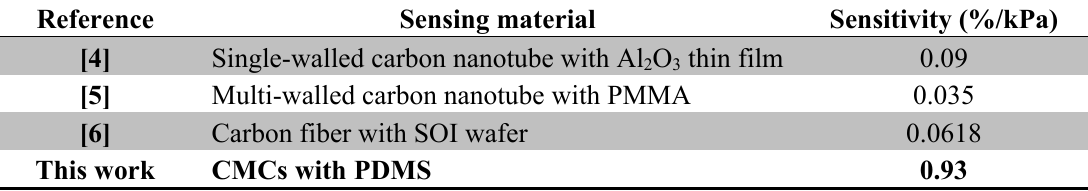
Table 1. Comparison of sensitivity of pressure sensors using